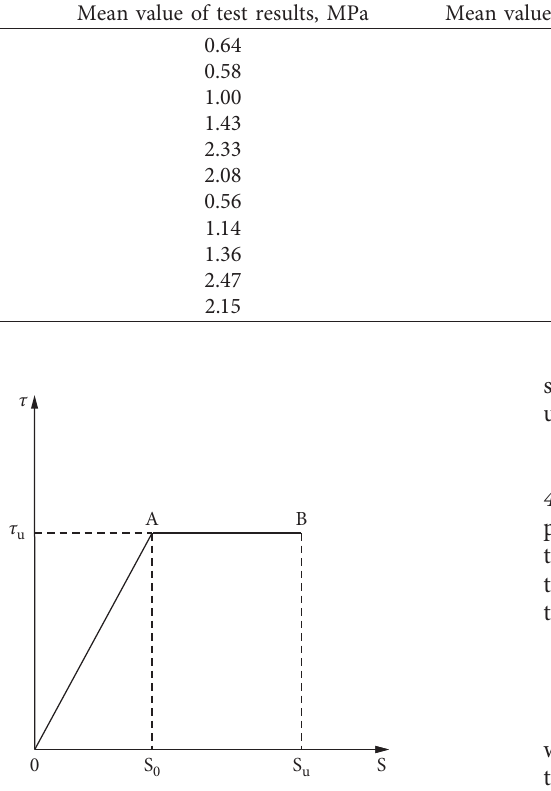
Figure 12: Constitutive model for the shearing stress-relative slip of the